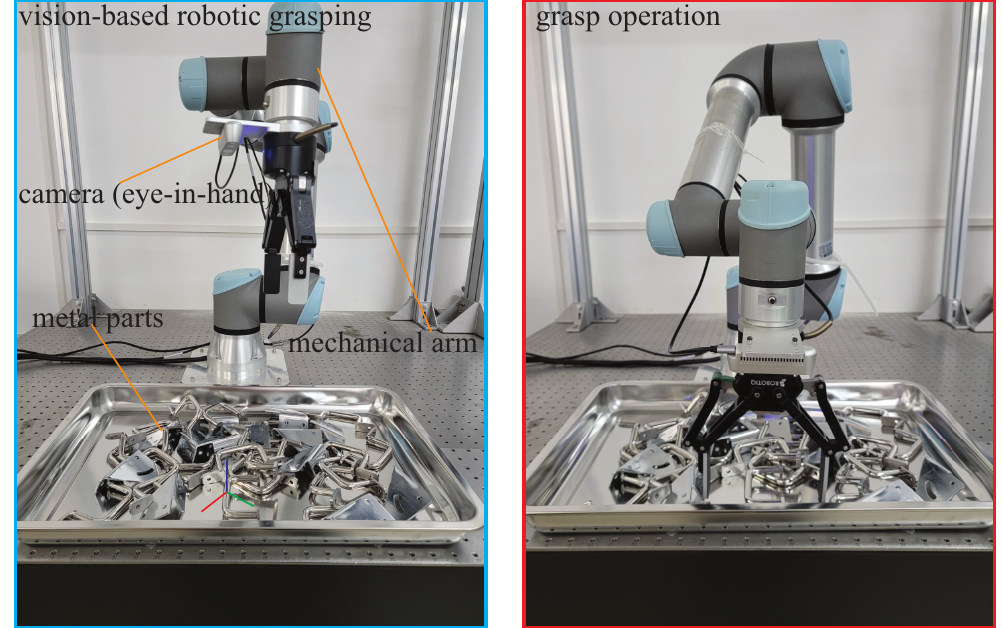
Figure 7. Experiment setting: the setup is a grasping metal setting.We use the eye-in-hand camera to capture the RGB image and drive the robot arm to grasp the metal parts.